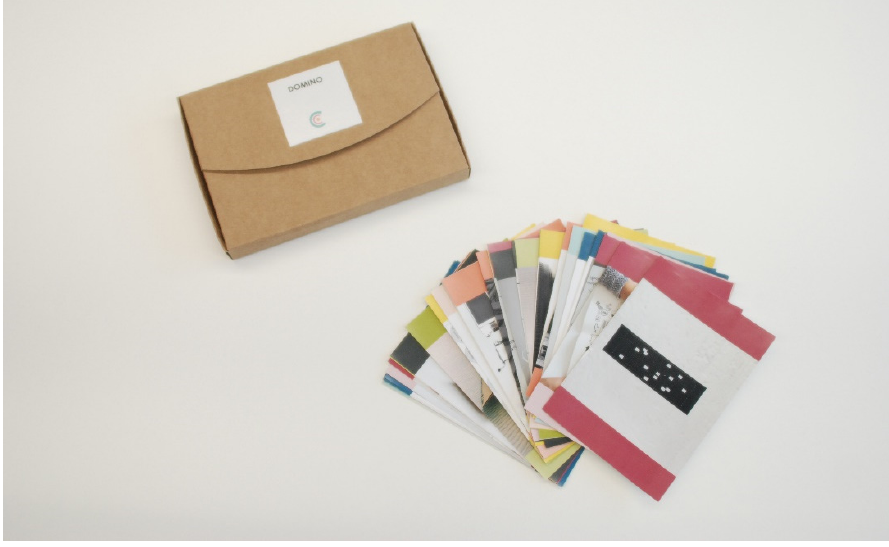
Figure 3. Photo of Domino cards.